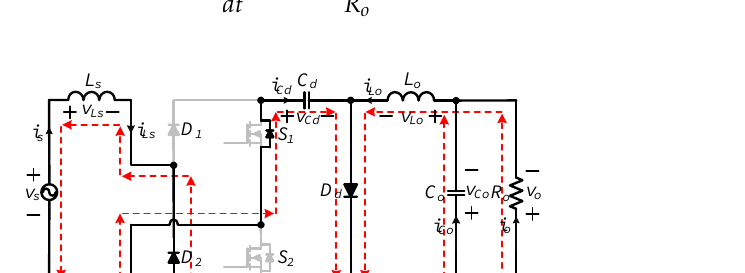
Figure 10. Equivalent circuit of the bridgeless Cuk converter in State 3 during negative half line cycle. To further reveal the potential merits of the proposed step up/down converter with modified dual loop control, Table 1 is provided to summarize comparisons for the bridge Cuk [11], bridgeless